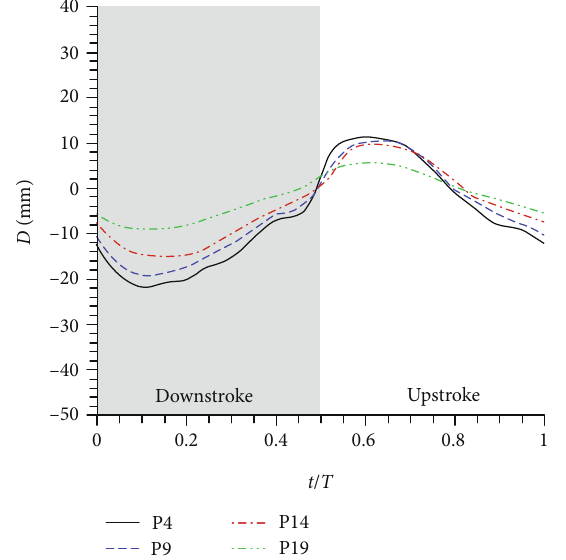
Figure 10: Deformation of points 4, 9, 14, and 19 on the leading edge.